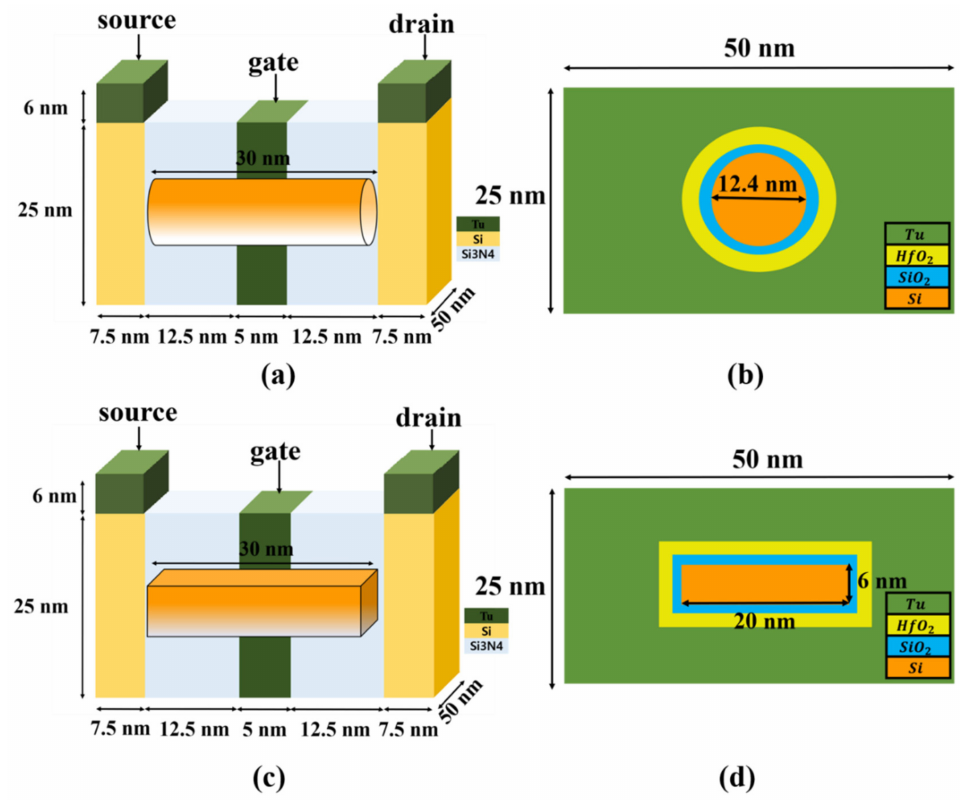
Figure 1. ( a ) External specifications of the NW FET, ( b ) internal channel diagram of NW-FET, ( c ) external specifications of the NS FET, and ( d ) internal channel diagram of NS-FET. NW-FET: nanowire